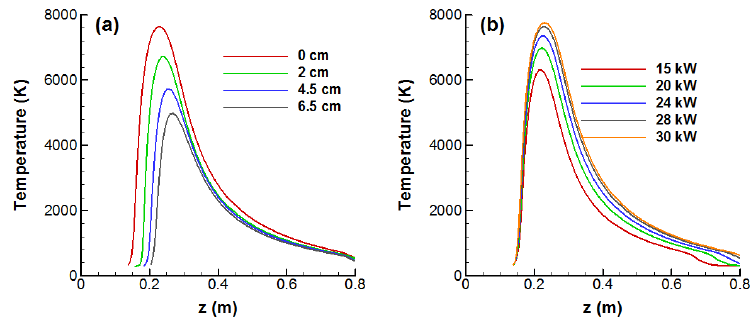
Figure 2. Simulation results showing the temperature profile along the axis line with the variation of ( a ) the distance from the plasma torch to the feeding nozzle and ( b ) the plasma power.